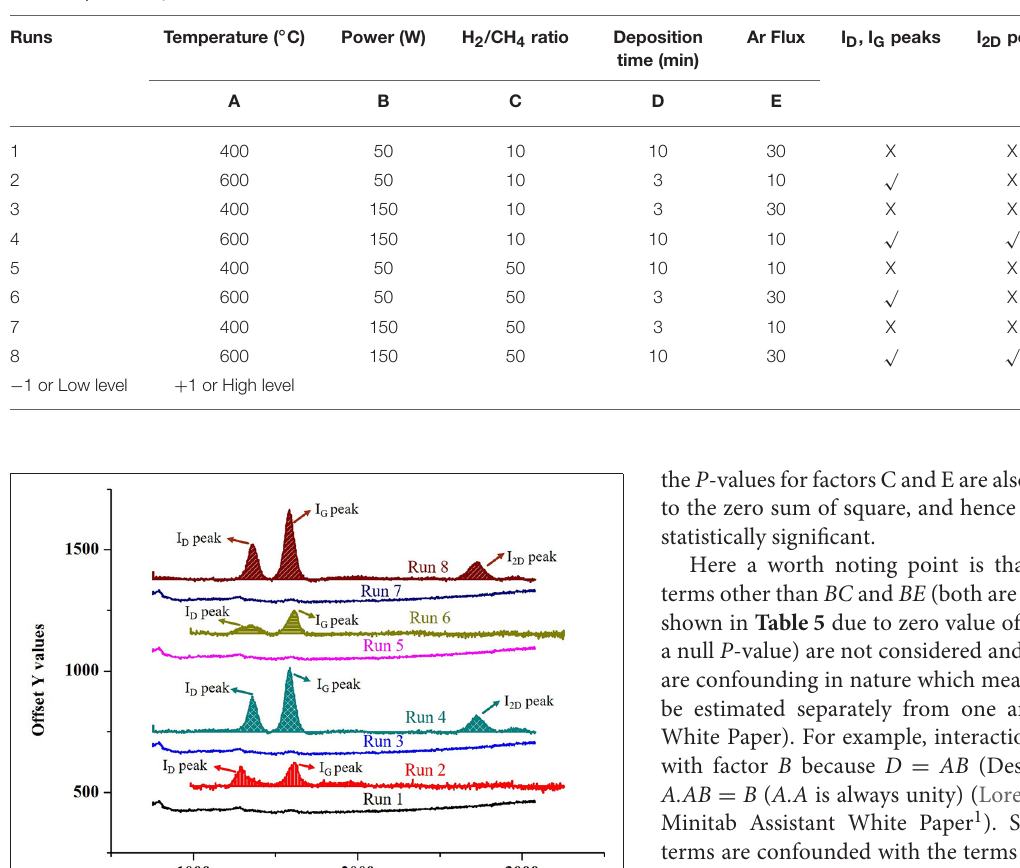
TABLE 4 | DoE analysis